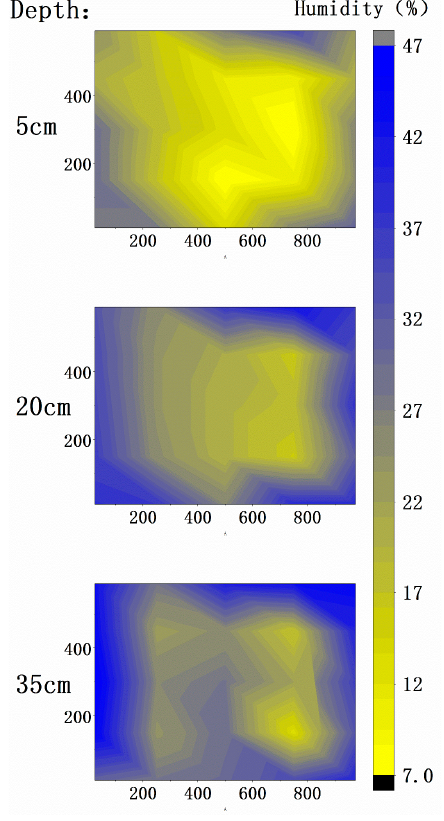
Figure 5. Distribution of treated soil moisture.